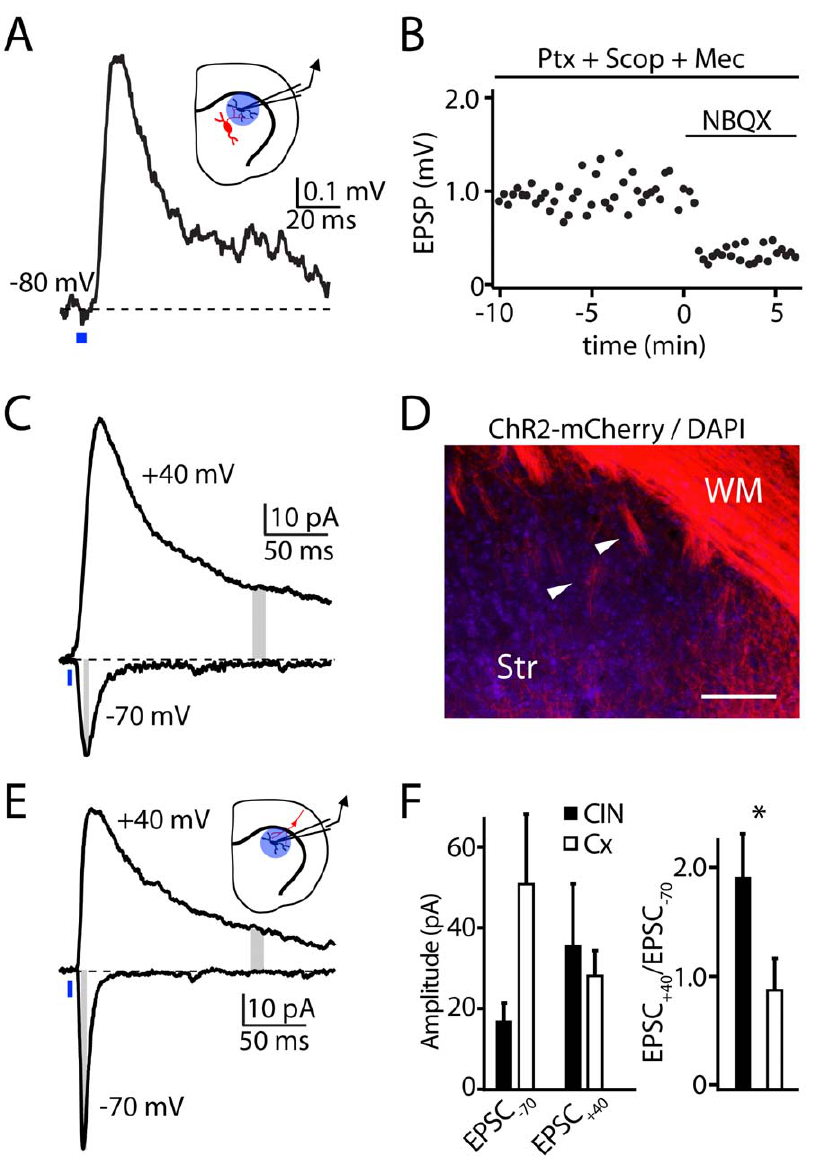
Figure 2. Light-evoked CIN action potentials evoke glutamatergic responses in MSNs. (A) inset, Schematic diagram of the recording conditions: whole-cell recordings were made from MSNs that neighbored ChR2-expressing CINs (red). The blue circle indicates the region stimulated by blue light. main panel, Example EPSP recorded in an MSN in response to a 4 ms light pulse (blue bar). (B) Amplitudes of light-evoked EPSPs in the presence of antagonists of GABA A (Picrotoxin, Ptx), muscarinic (Scopolamine, Scop), and nicotinic (Mecamylamine, Mec) receptors and following application of the AMPA/kainate glutamate receptor antagonist NBQX. (C) Example of light evoked (blue bar) CIN-mediated EPSCs in a voltage- clamped MSN at holding potentials of 2 70 and + 40 mV demonstrating the large current that is visible more than 100 ms after the light pulse at + 40 mV. The amplitudes of the rapid 2 70 and prolonged + 40 mV EPSC components were measured in the periods indicated by the gray bars. (D) Confocal image of mCherry-positive ChR2-expressing fibers in the motor cortex, white matter (WM) and underlying striatum (Str). Large bundles of corticofugal fibers (white arrowheads) and diffuse small axonal collaterals are visible throughout the dorsolateral striatum. Scale bar 200 m m. (E) inset, Schematic diagram of the recording conditions: whole-cell recordings were made from MSNs neighboring ChR2-expressing corticostriatal fibers (red), and blue light was delivered to the region indicated by the blue circle. main panel, Example EPSCs recorded in an MSN in response to a blue light pulse at the indicated holding potentials. (F) left , Average amplitudes of light-evoked EPSCs measured in MSNs held at either 2 70 or + 40 mV in response to ChR2-mediated activation of either CINs or corticostriatal fibers (Cx). right , Average ratio of + 40/ 2 70 mV current amplitudes measured following ChR2-mediated activation of either CINs or corticostriatal fibers.